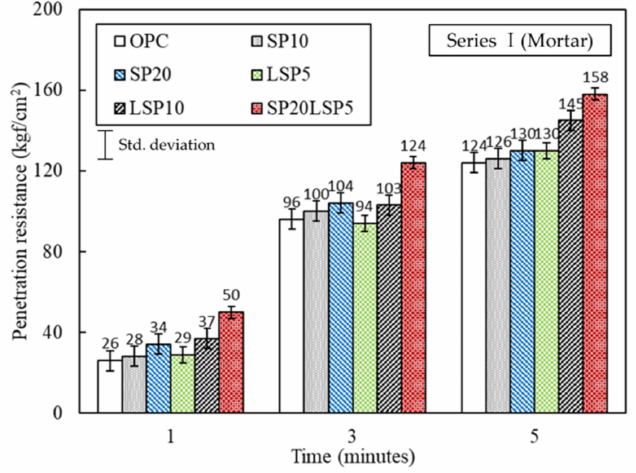
Figure 4. Penetration resistance value of mortar specimens.